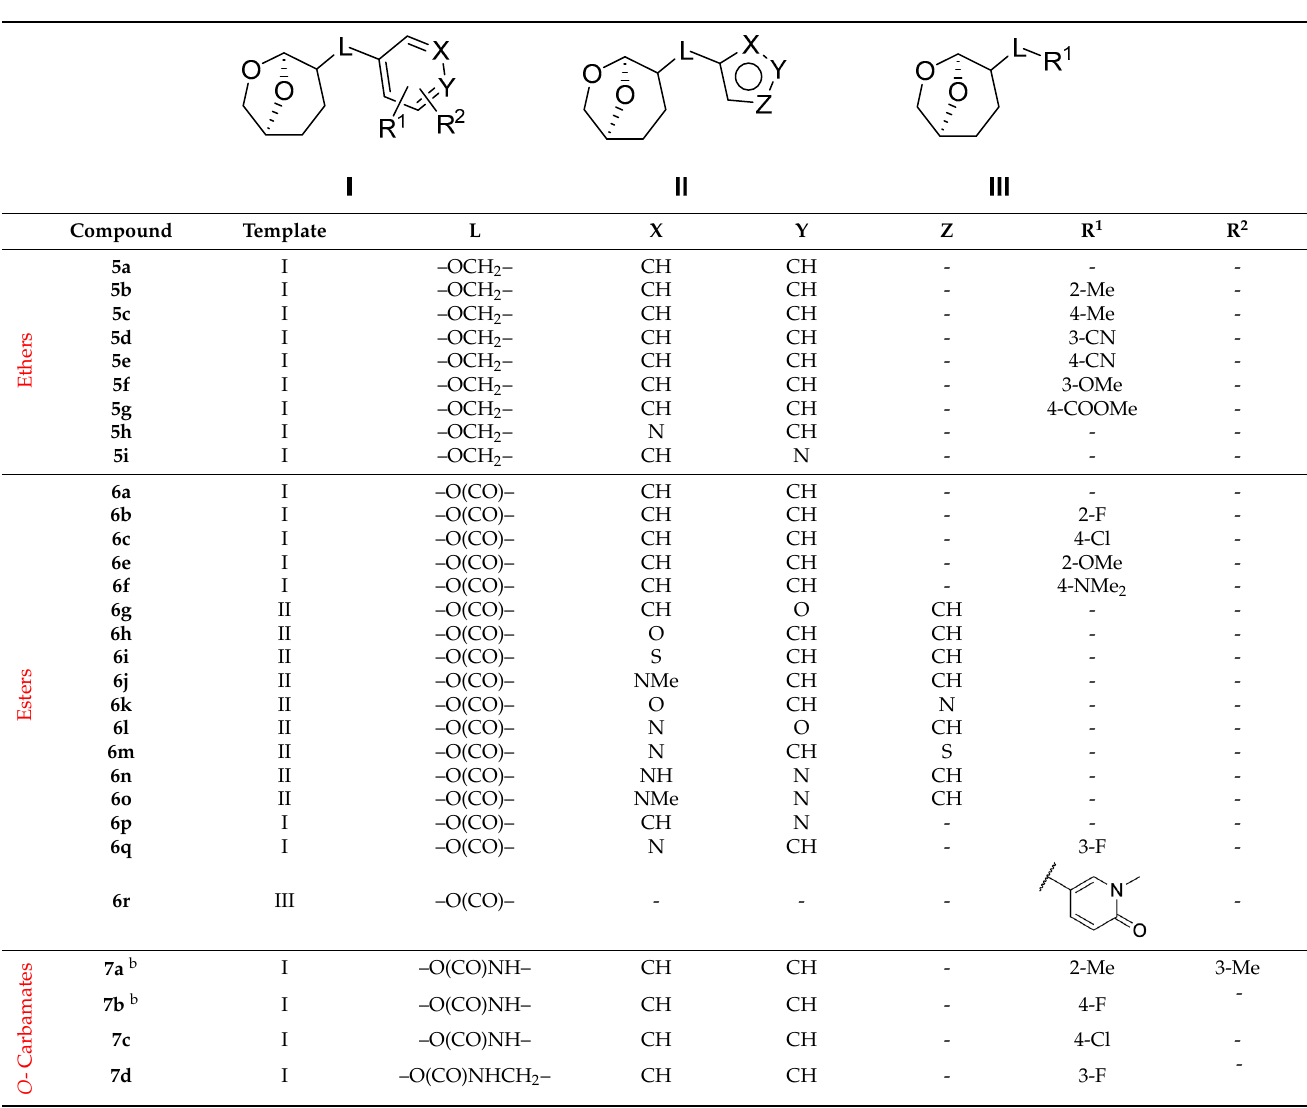
Table 1. All 100 compounds prepared in this study. Three templates (I, II, III) are used for clarity. Unless mentioned otherwise, compounds are a mixture of endo and exo diastereomers. Supplementary Materials Tables S2 and S3 show all full structures, d.r. values and, where appropriate, proposed relative stereochemistry of the (major) diastereomer.